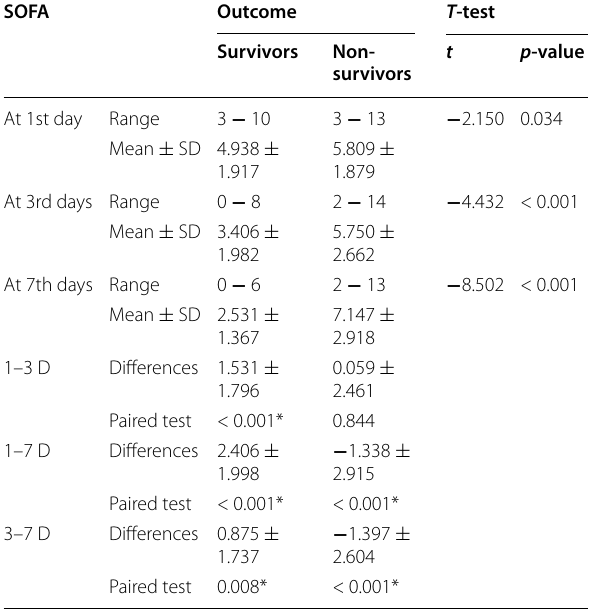
Table 6 Comparison between survivors and non-survivors from sepsis as regards SOFA score on admission, 3rd and 7th day of